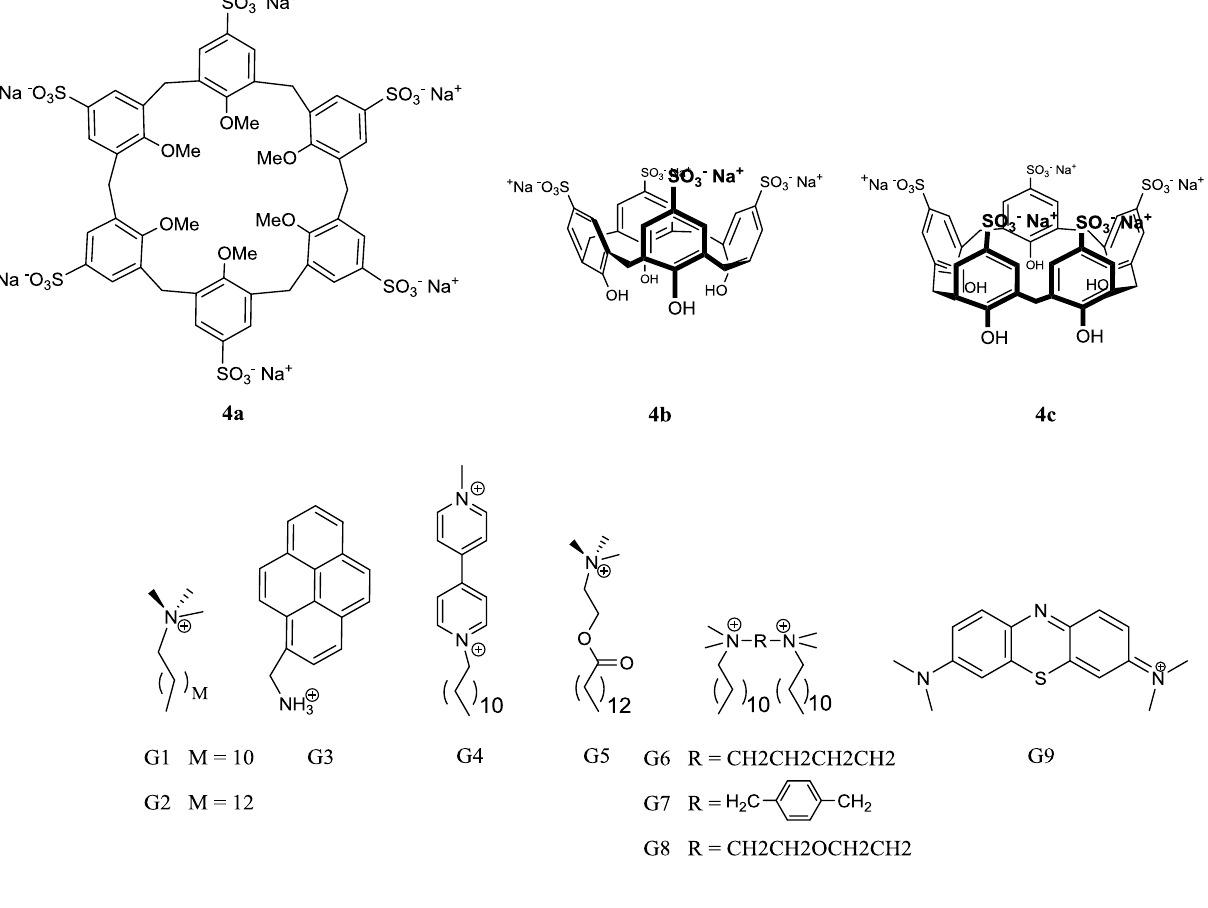
Figure 9. Structures of p -sulfonatocalixarene hosts and cationic guests used for the assembly of supramolecular